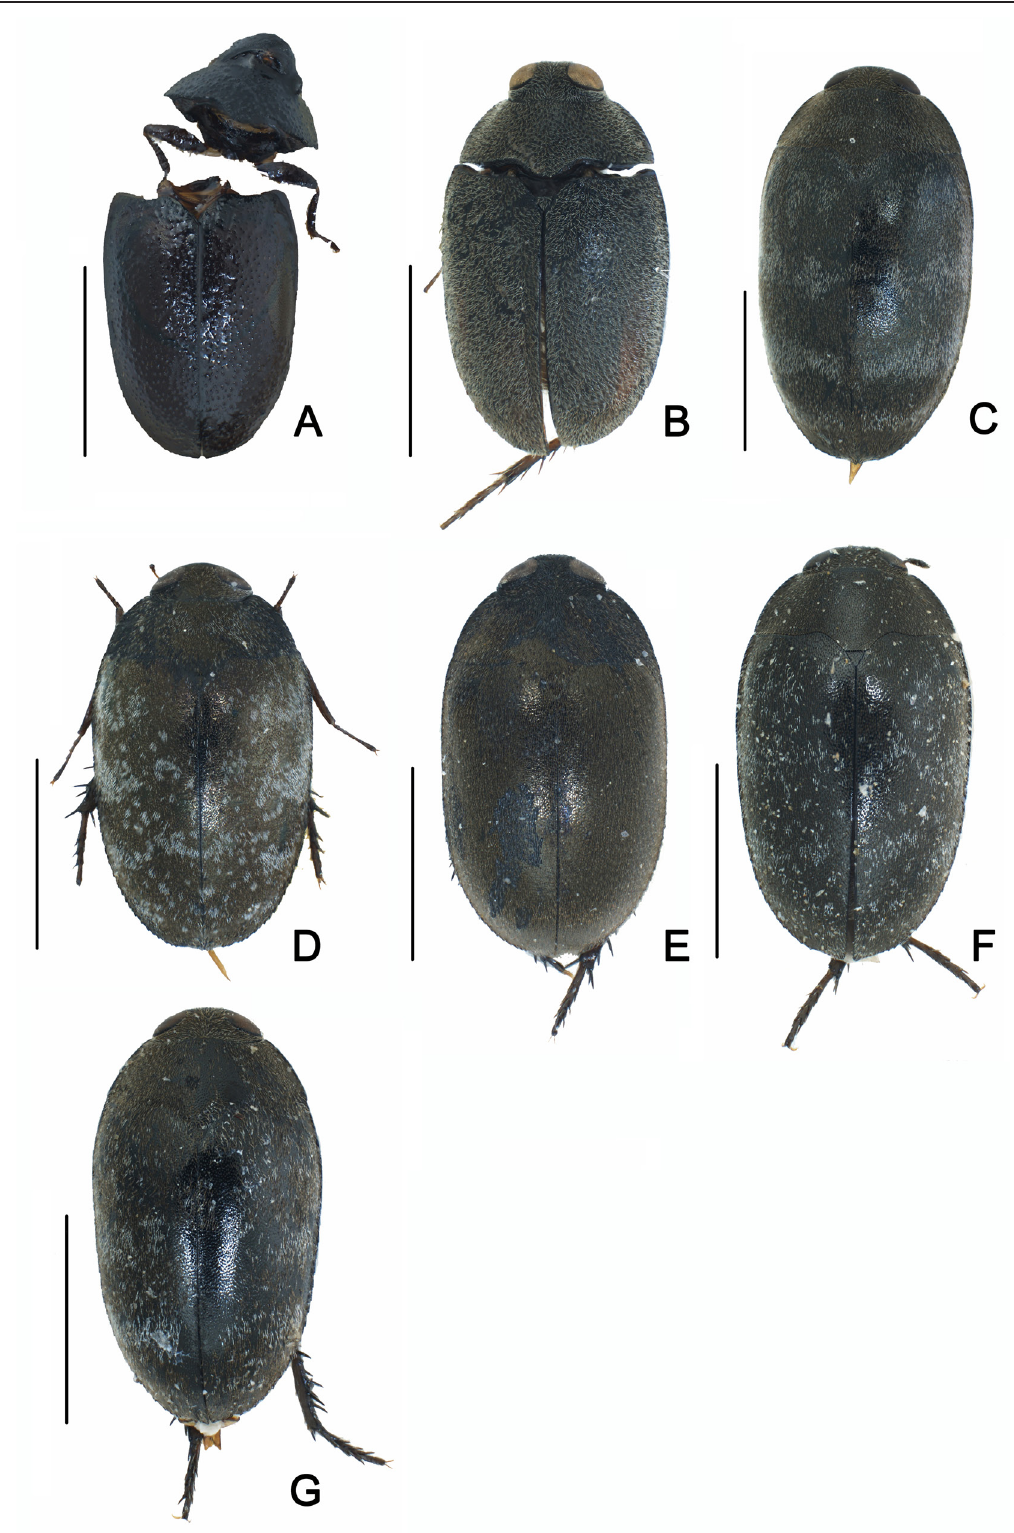
Fig. 11. Species of Mexico Spilman, 1972. A . M . borneensis sp. nov., holotype (BPBM). B . M . papuanus sp. nov., holotype (BPBM). C . M . ogasawaraensis sp. nov., holotype (EUMJ). D . M . baliensis sp. nov., holotype (EUMJ). E . M . palauensis sp. nov., holotype (EUMJ). F . M . masamii (Satô, 1994) (EUMJ). G . M . taiwanus (Satô, 1994), paratype (EUMJ). Scale bars: